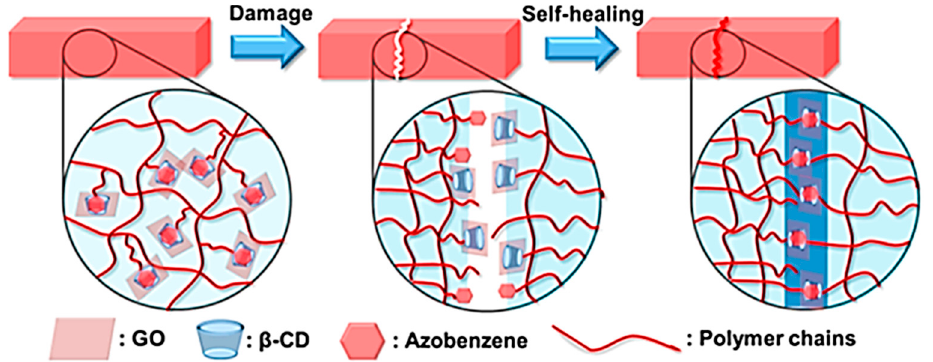
Figure 4. Schematic illustration of self-healing mechanism of epoxy nanocomposite films. Reprinted with permission from [96]. 2022, ACS. Table 1. Heating or photothermal effect triggered self-healing efficiencies of epoxy nanocomposite films at different times EAG = epoxy/functional graphene oxide. Reprinted with permission from [96]. 2022, ACS.